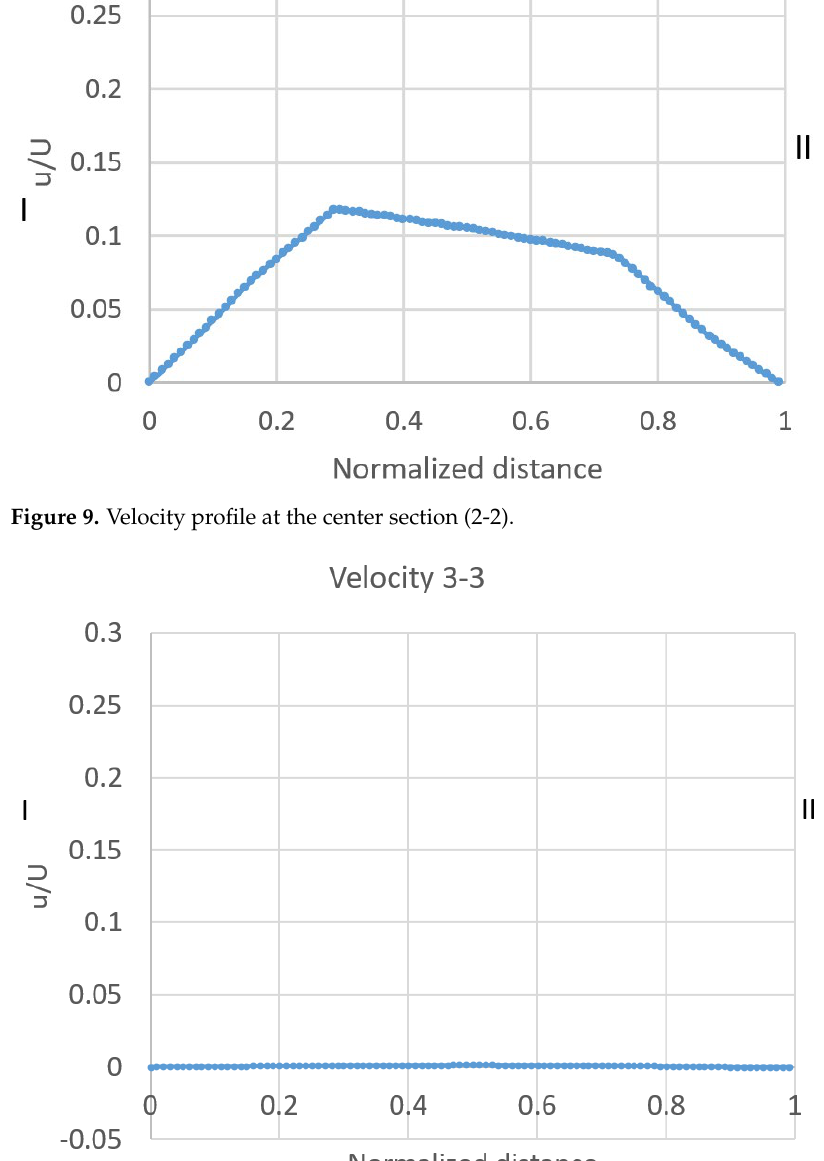
Figure 10. Velocity profile at the downstream section (3-3).